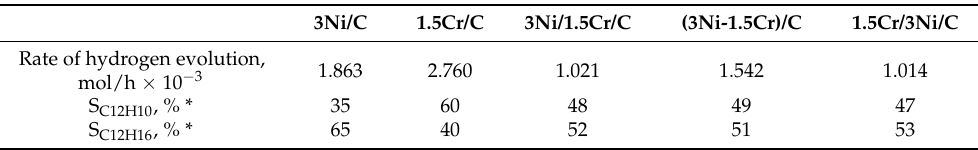
Table 2. Catalytic properties of Ni-Cr/C catalysts of bicyclohexyl dehydrogenation (T = 320 ◦ C, p = 1 atm, WHSV = 2.8 h − 1